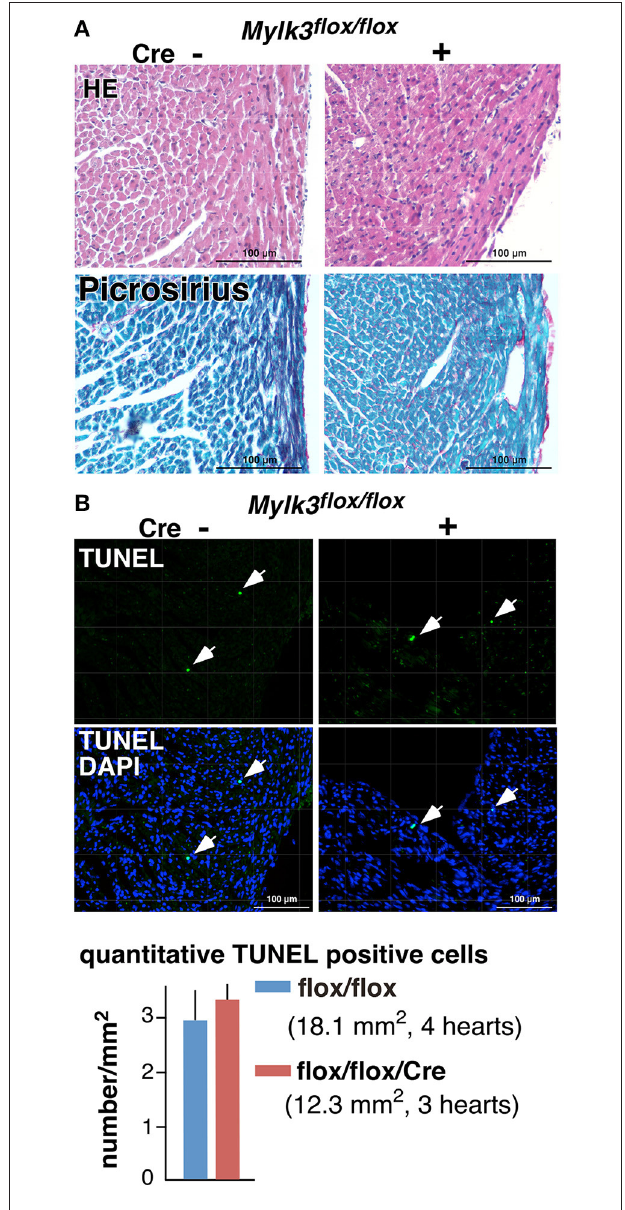
FIGURE 3 | No apparent interstitial fibrosis or increase of TUNEL-positive cells in perinatal Mylk3-KO mice. (A) Representative H&E- and Picrosirius red-stained heart sections from control and perinatal Mylk3-KO mice. No apparent fibrosis were seen in inducible marked with arrowheads. (B) Representative TUNEL-staining, and the quantitative TUNEL-positive cells indicated by arrows relative to the area size scanned per mouse heart (per mm 2 ). Total area size examined, Mylk3 flox / flox , 18.1mm 2 from 4 mice; Mylk3 flox / flox /Cre, 12.3mm 2 from 3 mice. Data presented are expressed as mean values ±